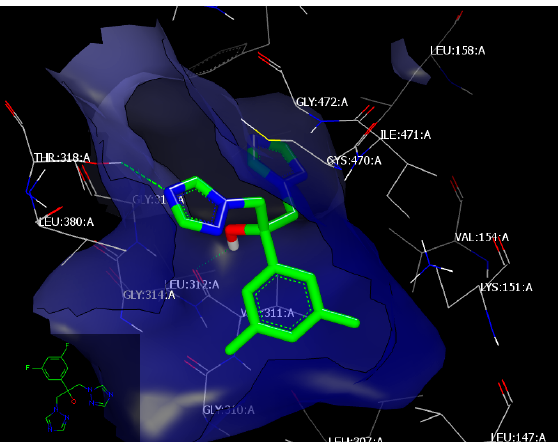
Figure 2. Visual representation of fluconzol docked with 4WMZ, showing two hydrogen bonding interactions with THR 318:A and LEU 312:A, as shown by Vida.